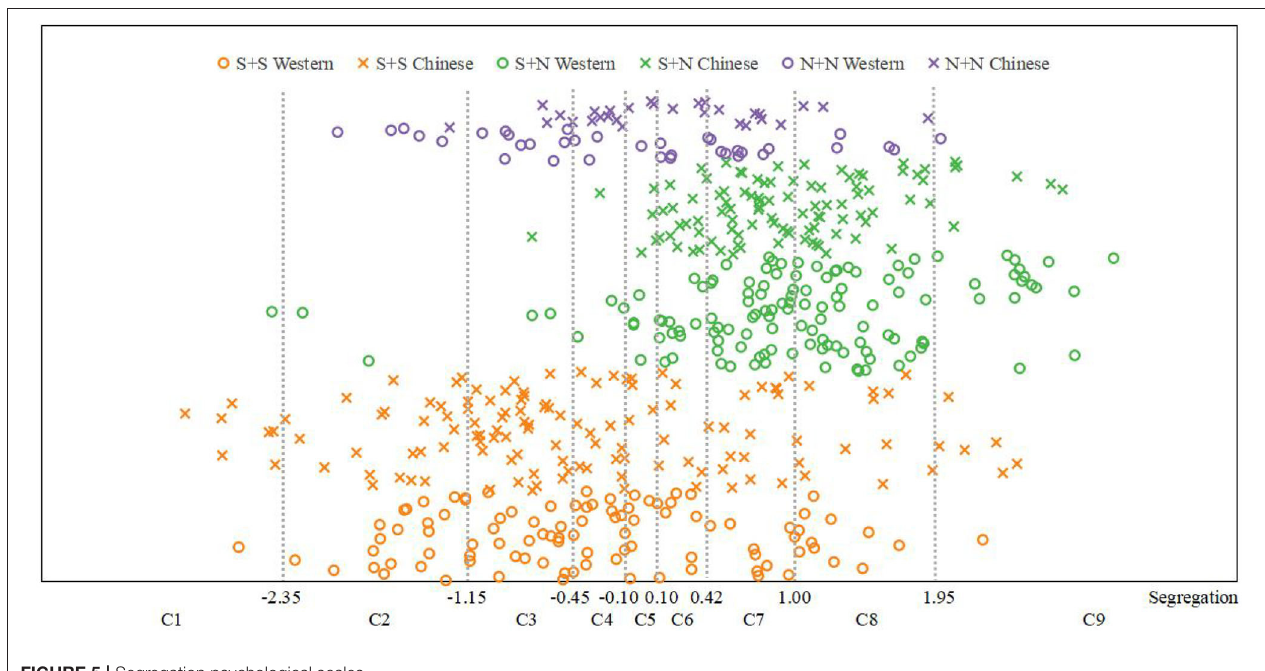
FIGURE 5 | Segregation psychological scales.